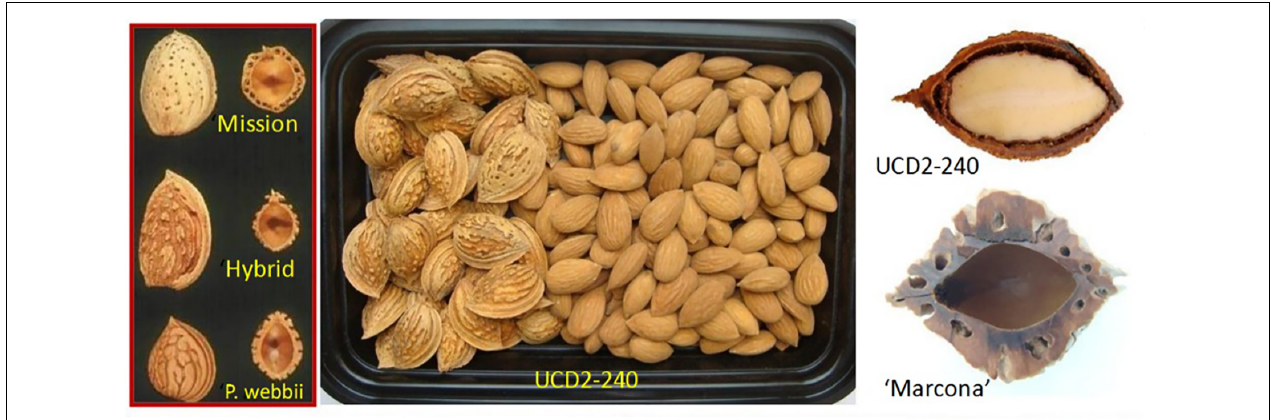
FIGURE 3 | Longitudinal and cross-section images of shells of the wild almond species P. webbii (#63 in Table 1 and Figure 1 ), the thin “paper”-shelled California “Mission” variety (#19), their interspecies hybrid, and the interspecies introgression selection UCD2-240 (#54) along with a shell cross-section of the Spanish variety “Marcona” for comparison (#25 in Table 1 and Figure 1 ).